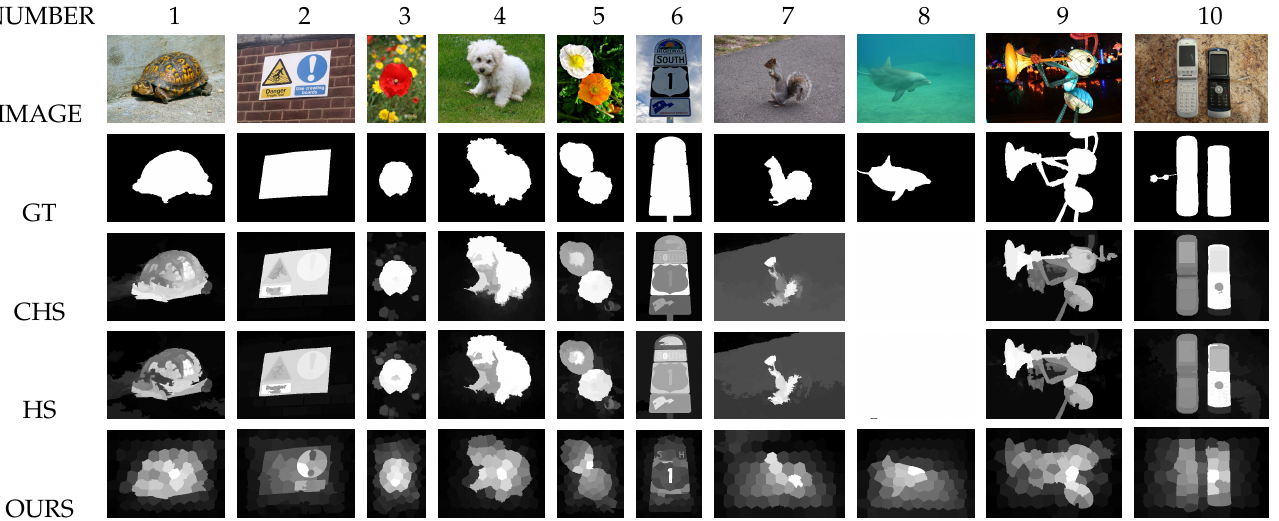
Figure 14. Comparison of some result images for HS [8], CHS [52] and our model. For image number 8, the HS [8] and CHS [52] models find white salient maps (GT: Ground Truth).